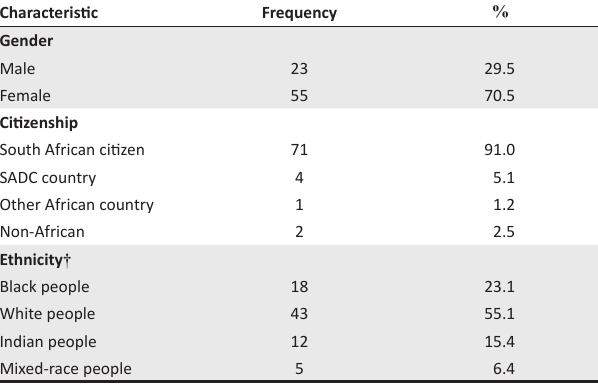
TABLE 1: Characteristics of participants (interview group; n =